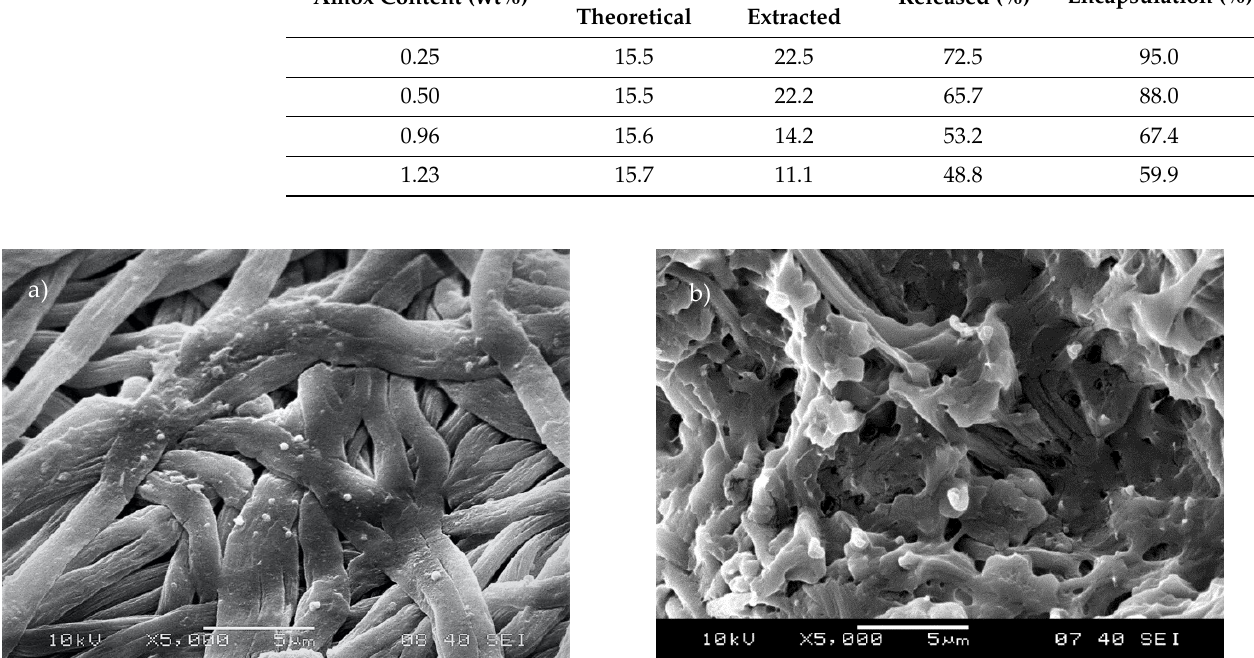
Figure 5. SEM micrographs showing the presence of Amox particles in PLA disks. ( a ) particles located among the fibers, ( b ) particles found within the fibers.